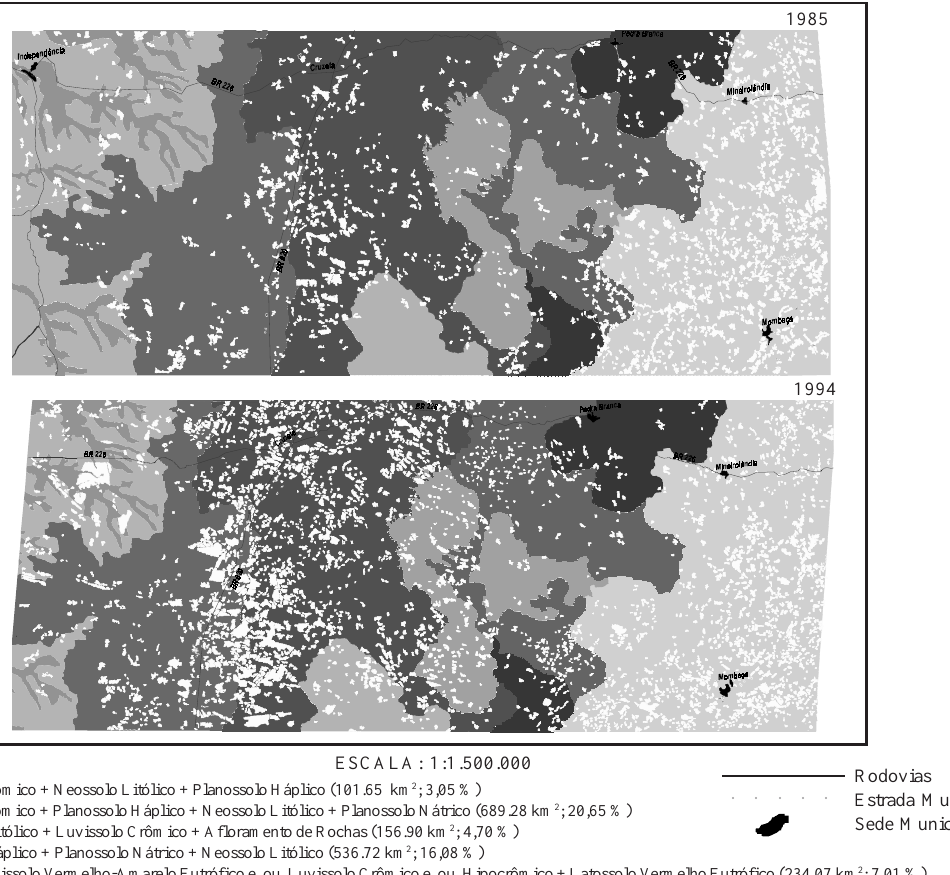
Figura 4. Sobreposição das Cartas de Solos e áreas cultivadas e pastagens (Interpretação a partir da imagem Landsat TM-5, WRS 217/064A; passagens em 20 de julho de 1985 e 14 de agosto de